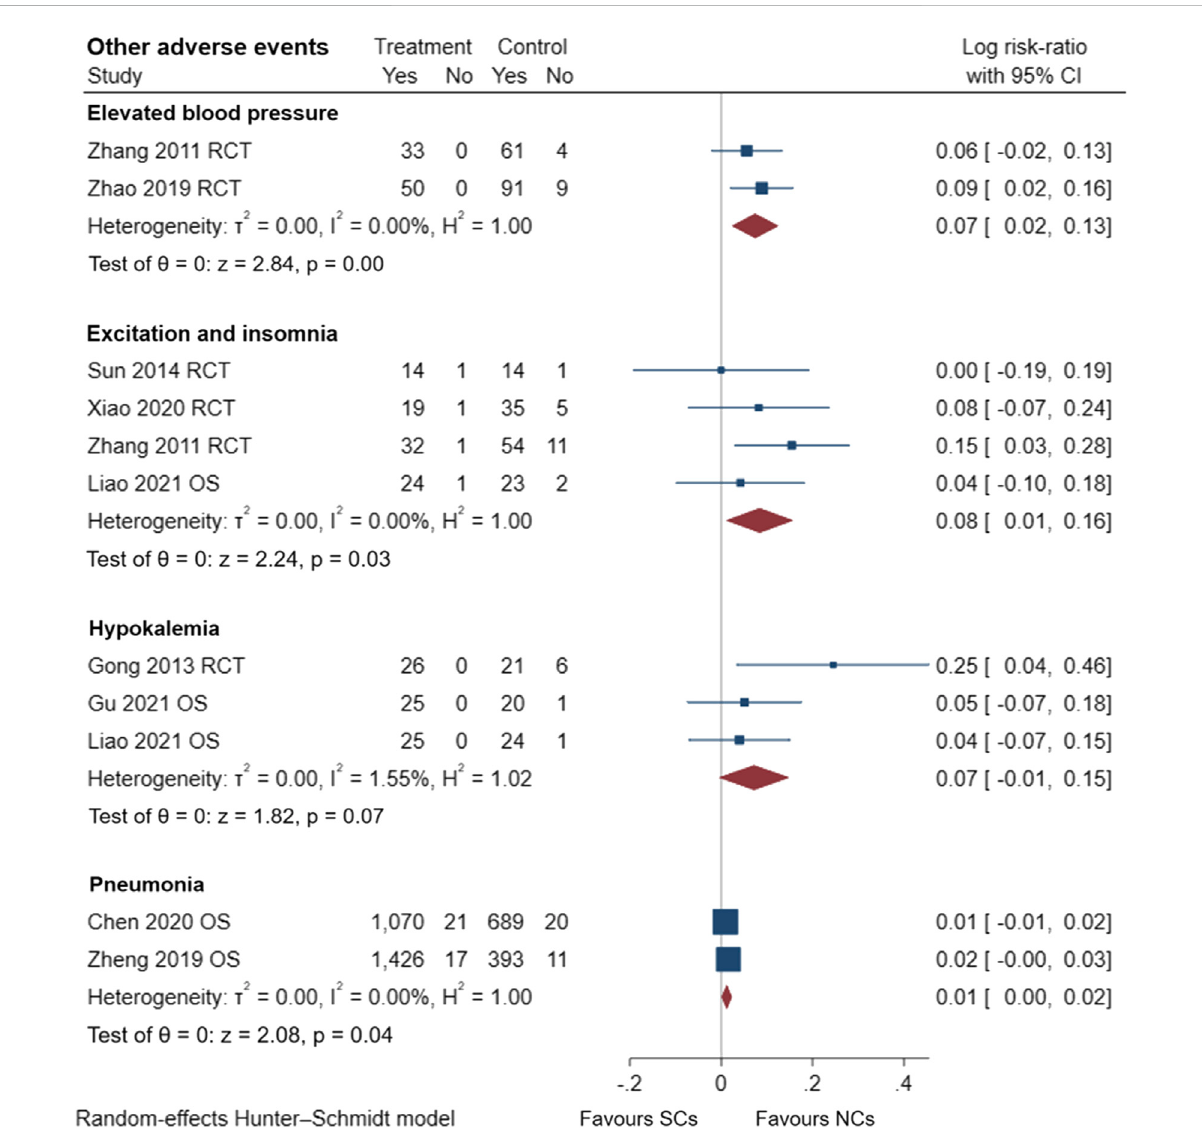
Other adverse events of SCs and NCs in observational studies and randomized controlled